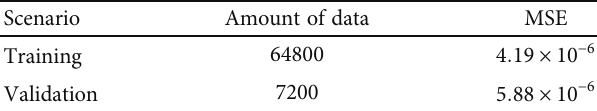
Table 1: Training statistics.